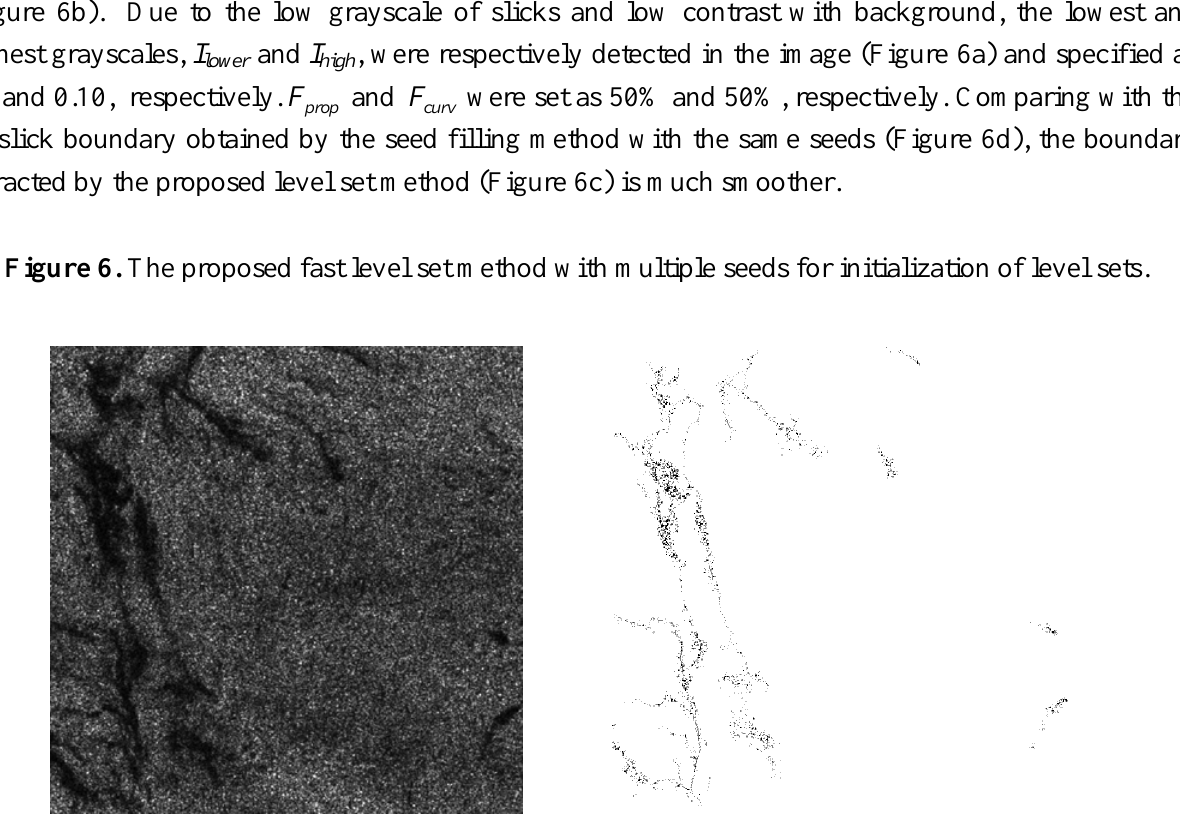
(a) ERS-2 SAR image at the Bohai Sea on June 5, (b) Initialization of level sets with a grayscale 1996. threshold of